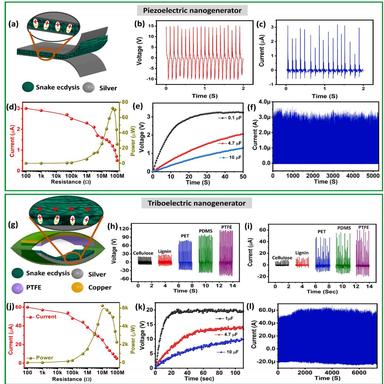
The electrical performance of snake ecdysis-based piezoelectric nanogenerator. (a) The device structure of the piezoelectric nanogenerator. (b) The voltage and (c) the current of the device. (d) The power of the device. (e) The different capacitor charging and (f) The stability of the piezoelectric device. The electrical performance of snake ecdysis-based triboelectric nanogenerator. (g) The device structure of the triboelectric nanogenerator. (h) The voltage and (i) the current of snake ecdysistribopositiv